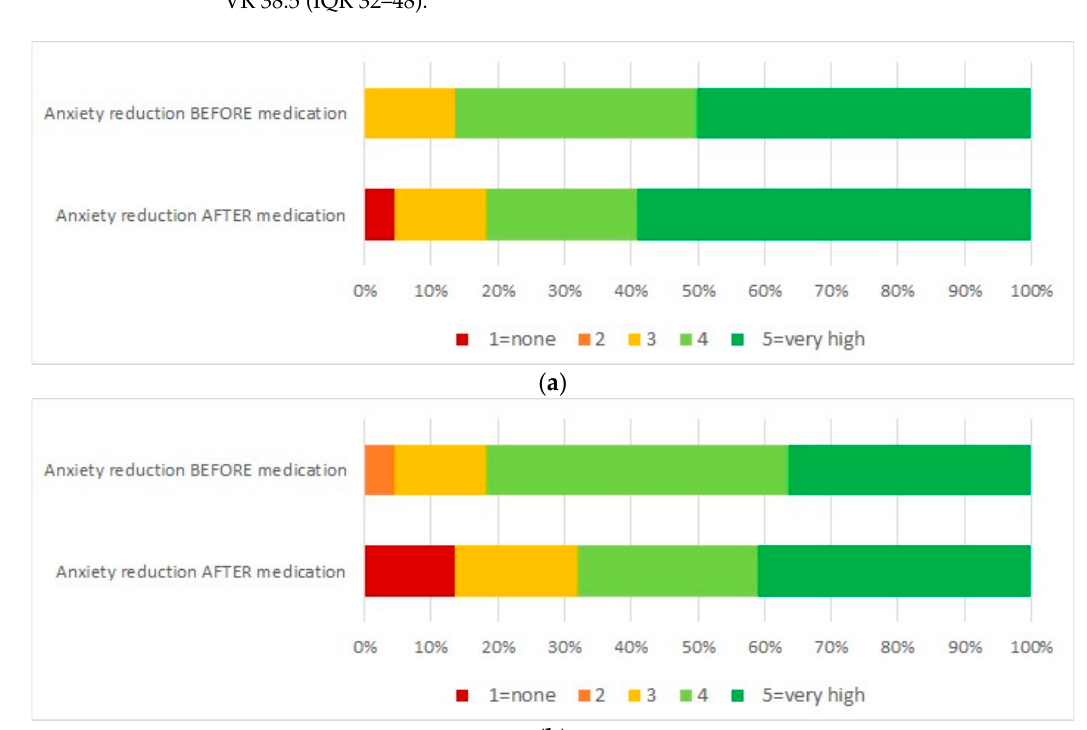
Figure 3. Perceived efficacy of VR by families and children ( a ) families; ( b ) children.